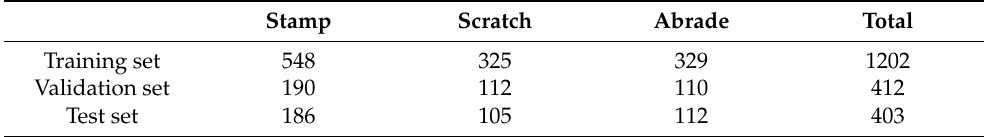
Table 1. The number of samples for each type of defect in the